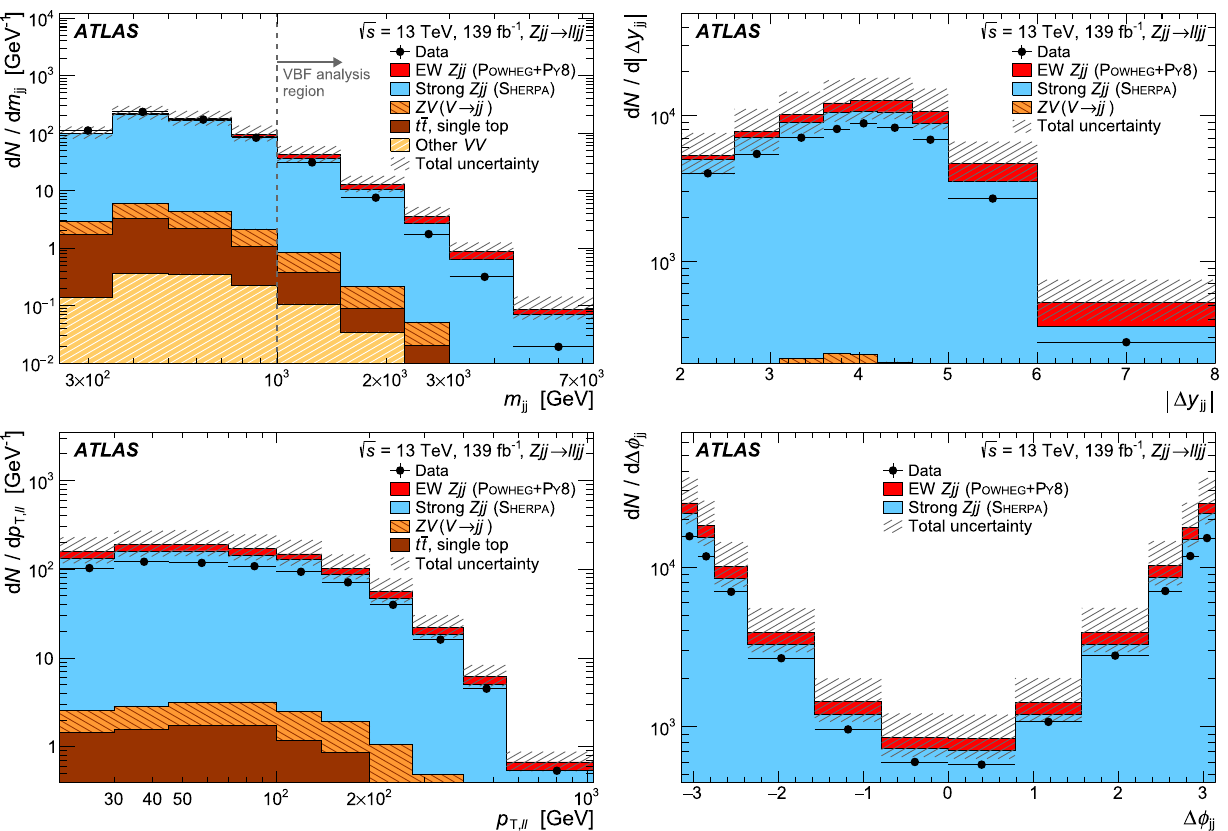
Fig. 2 Event yields as a function of m jj (top left), | (cid:4) y jj | (top right), p t ,(cid:3)(cid:3) (bottom left) and (cid:4)φ jj (bottom right) in data and simulation, measured aftertheeventselectiondescribedinSect.4.Thedataarerepresentedasblackpointsandtheassociatederrorbarincludesonlystatisticaluncertainties. The m jj spectrum is shown starting from 250 GeV, and hence includes more events than the other plots that use the default m jj > 1000GeV criterion